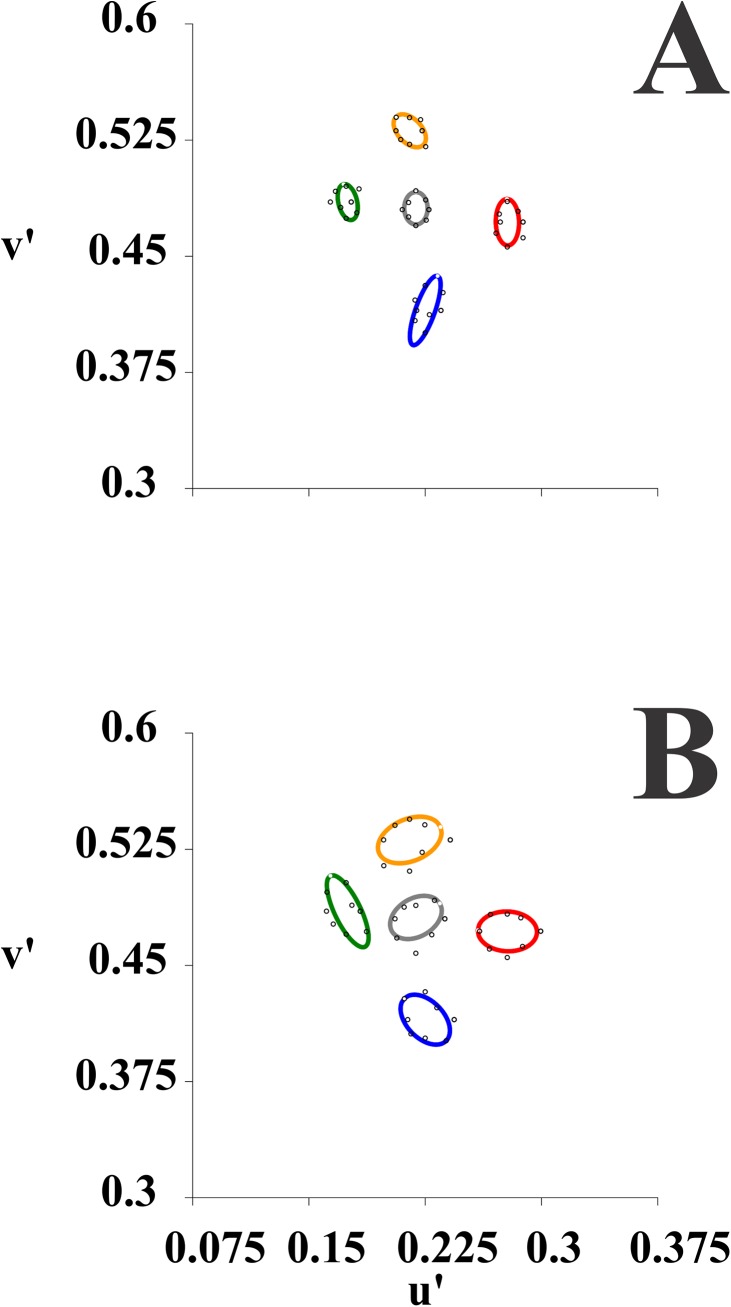
Colour discrimination ellipses from young alcohol consumers obtained with the MR test compared with young non-alcohol consumers.Examples of individual performance. Five regions of the colour space were studied. Data points from colour discrimination thresholds were plotted in the CIE 1976 colour space and then fitted to obtain the corresponding MacAdam colour discrimination ellipses. A) Colour discrimination ellipses obtained from a control subject (C04 020620 Right Eye, 20 years old). Β) Colour discrimination ellipses obtained from a young alcohol consumer (S02100805, right eye, 22 years old). Some alcohol consumers had colour discrimination ellipses larger than controls, but data for the majority of them fell in the normal range. There was no preference in the colour space for threshold increase in young consumers.